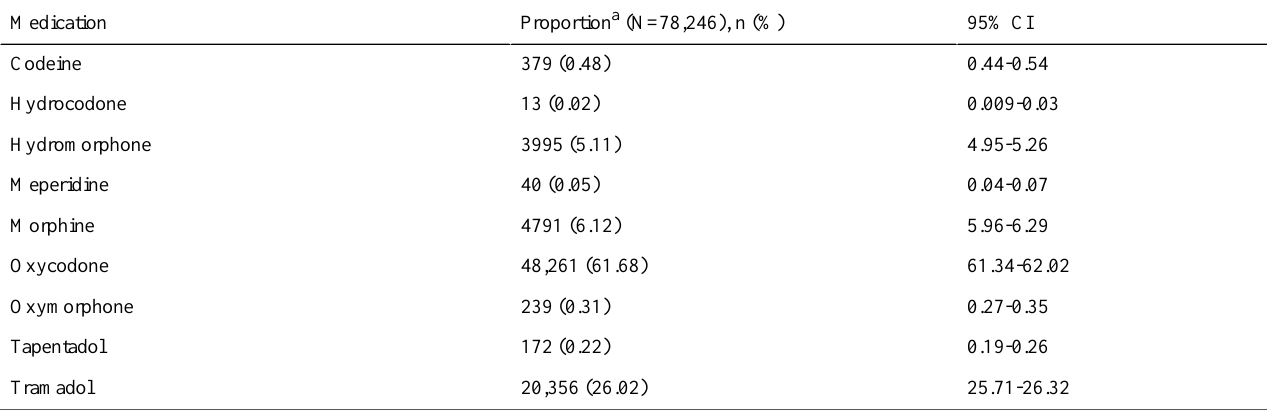
Table 1. Proportion of each opioid during the study period with 95% confidence intervals.